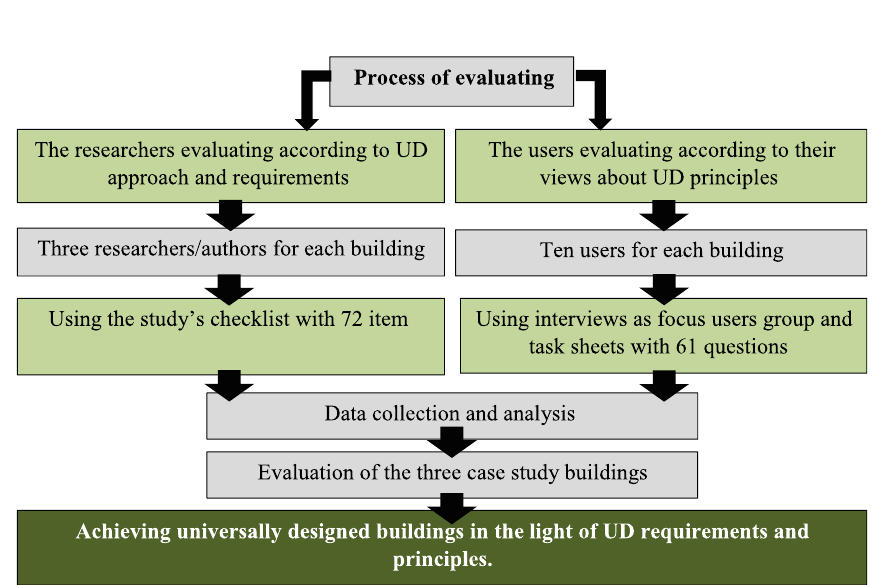
Fig. 2 The framework of the evaluation process of the case study